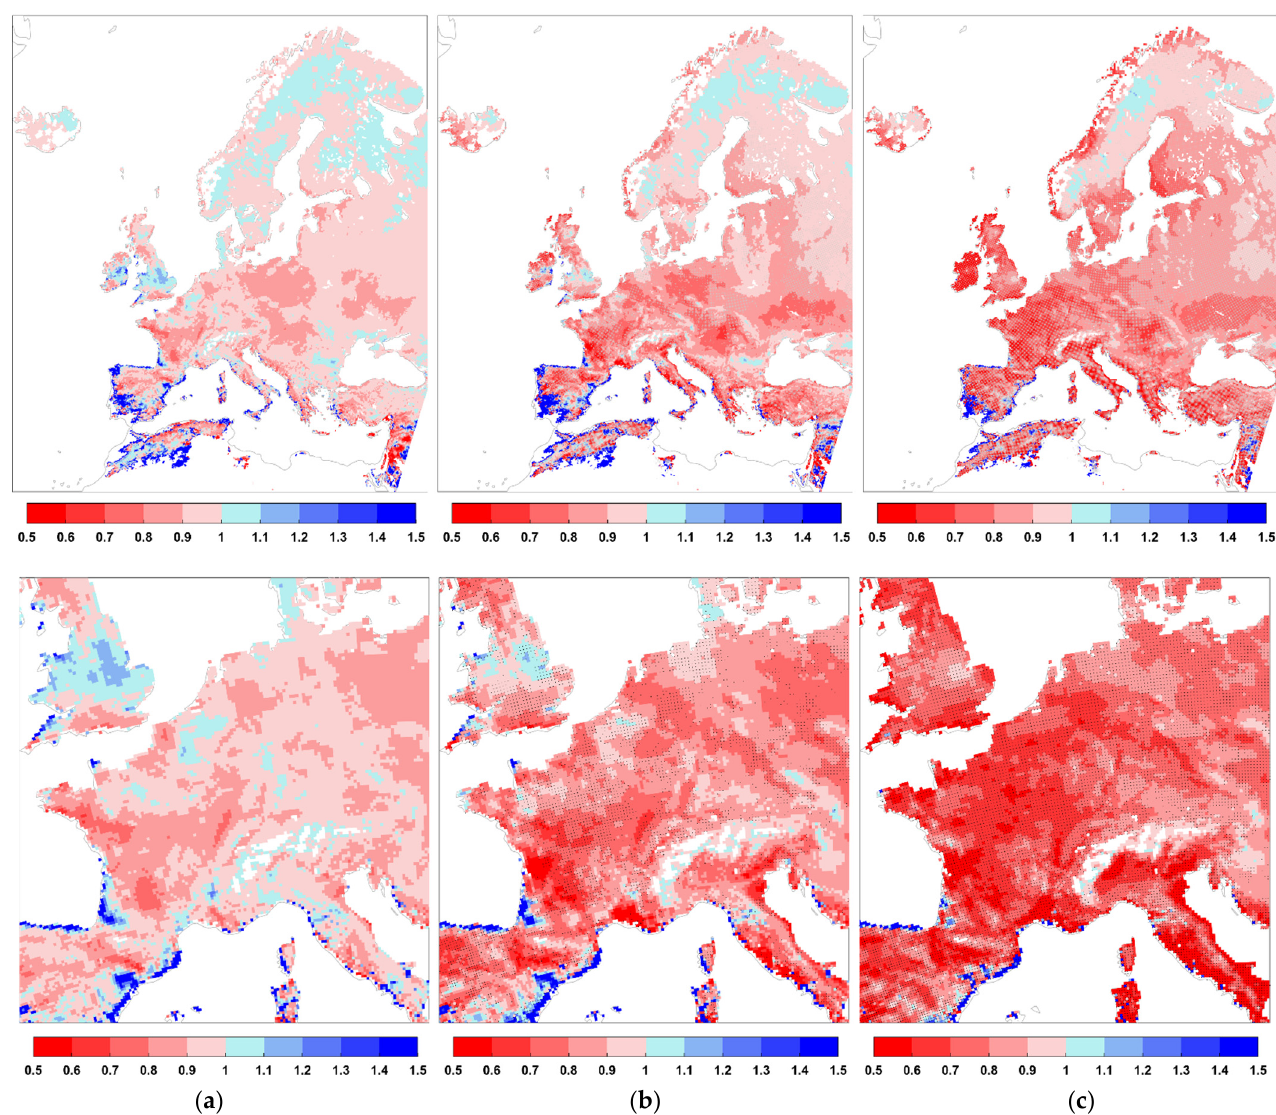
Figure 4. FC maps (ensemble mean) for characteristic ground snow loads, associated to 0.02 probability of exceedance in one year, in the Euro-Cordex domain (first row) and a focus on central Europe (second row). Three moving time windows are considered (1971–2010 ( a ), 1991–2030 ( b ), and 2011–2050 ( c )) in the elaboration with respect to 1951–1990, based on RCP4.5 scenario. The dots indicate statistically significant changes in the distribution of annual maxima at the 5% level.